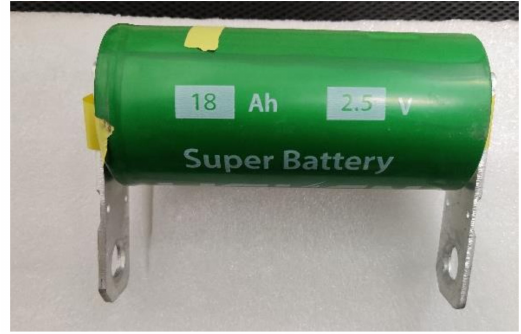
Figure 1. The lithium titanate cell used in this